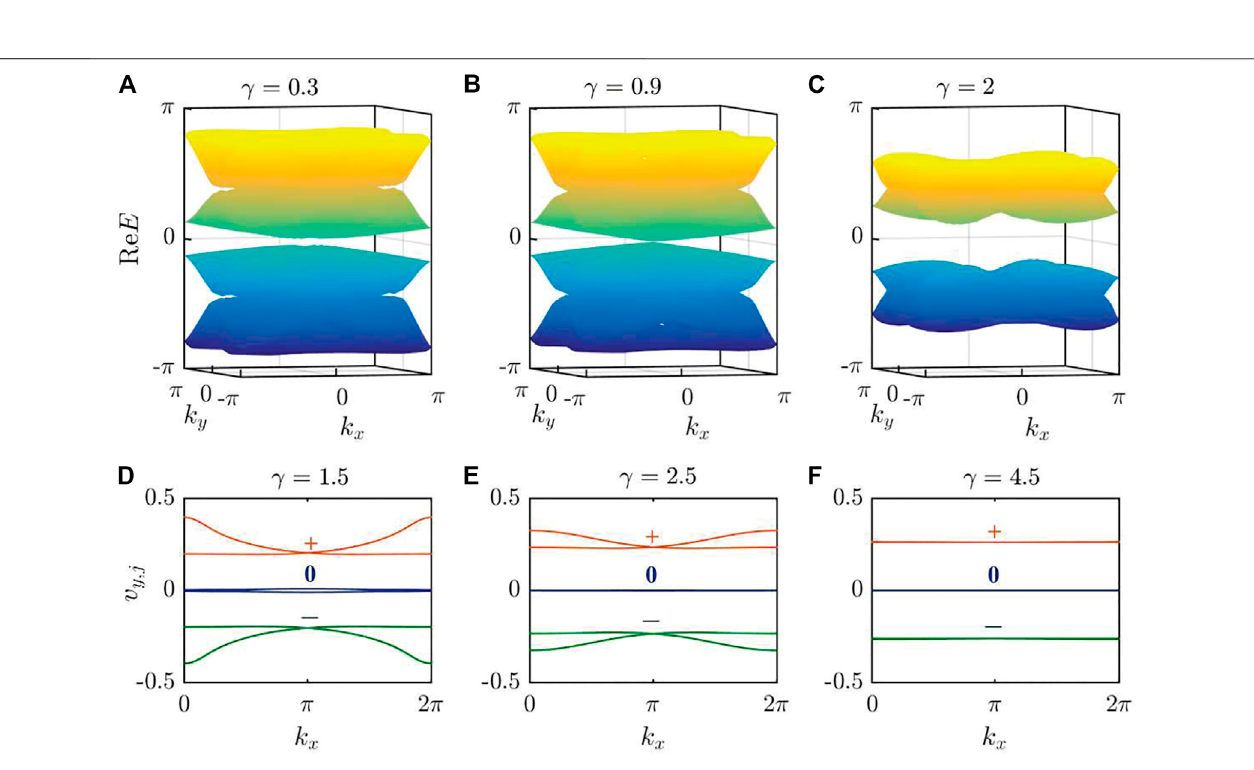
Frontiers in Physics |